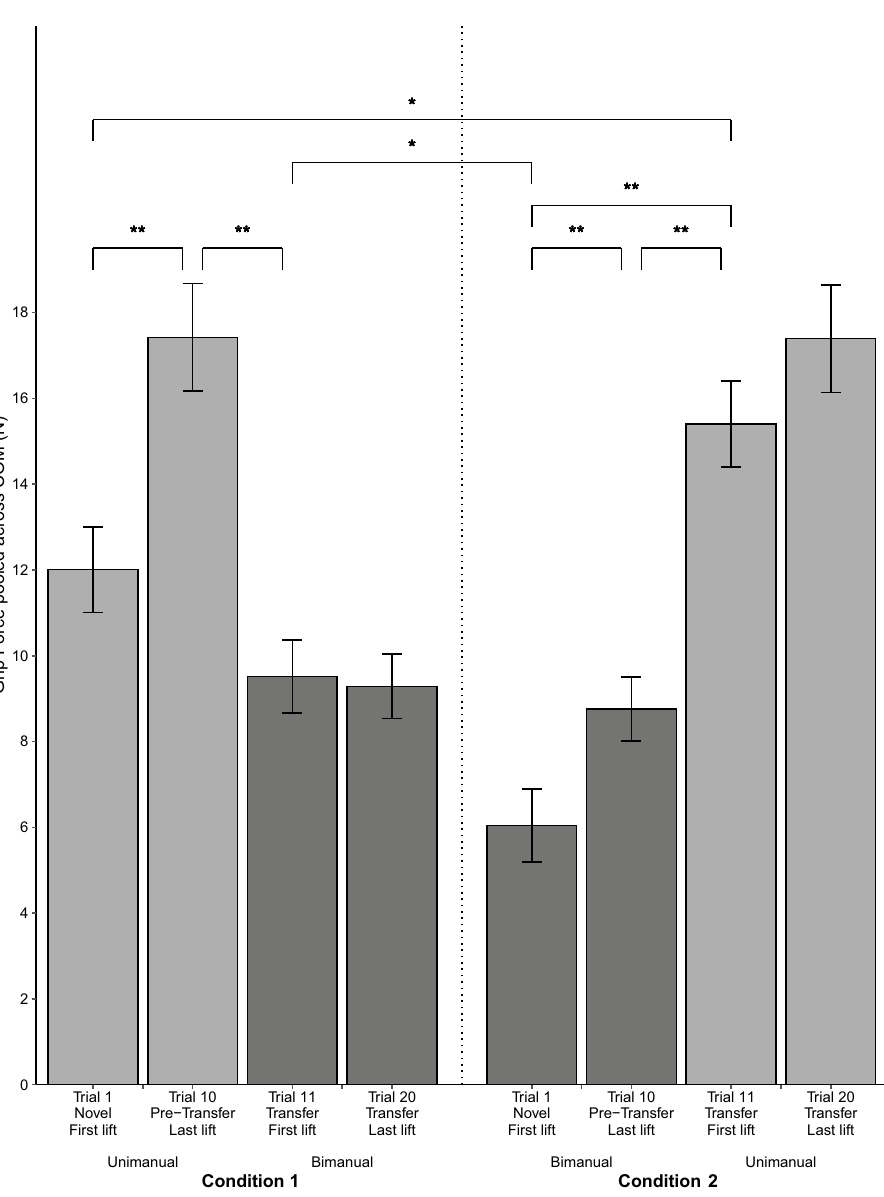
Figure 7. Results for Grip Force (GF) across the conditions. Average GF for condition 1(left panel) and condition 2 (right panel) for the novel first trial, pre-transfer trial 10, transfer trial 11, and trial 20 (± s.e.m). Results were pooled across COM after no significant effect was found between the left and right COM. Light grey bar indicates GF for the right-hand unimanual trials. Dark grey bar indicates GF for the bimanual trials. Error bars indicate the standard error of the mean. * p < .05, ** p <